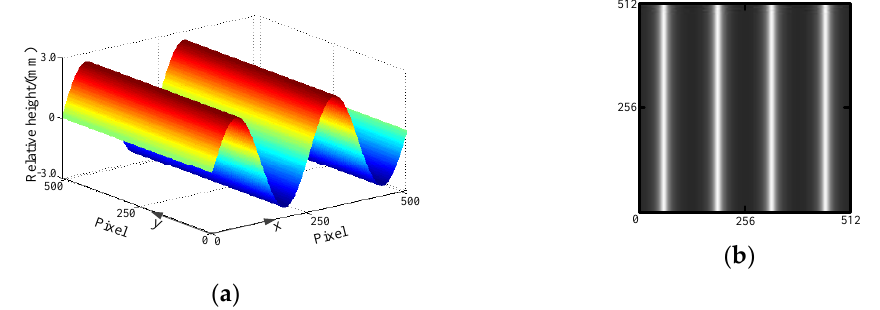
Figure 5. ( a ) Multiple peaks and surface valleys; and ( b ) Synthetic image.